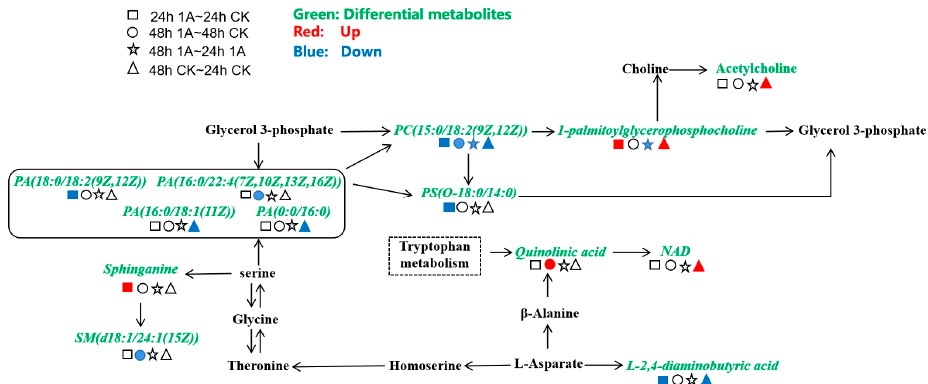
Figure 9. The main KEGG metabolic network pathways of differential metabolites under ABM stress.